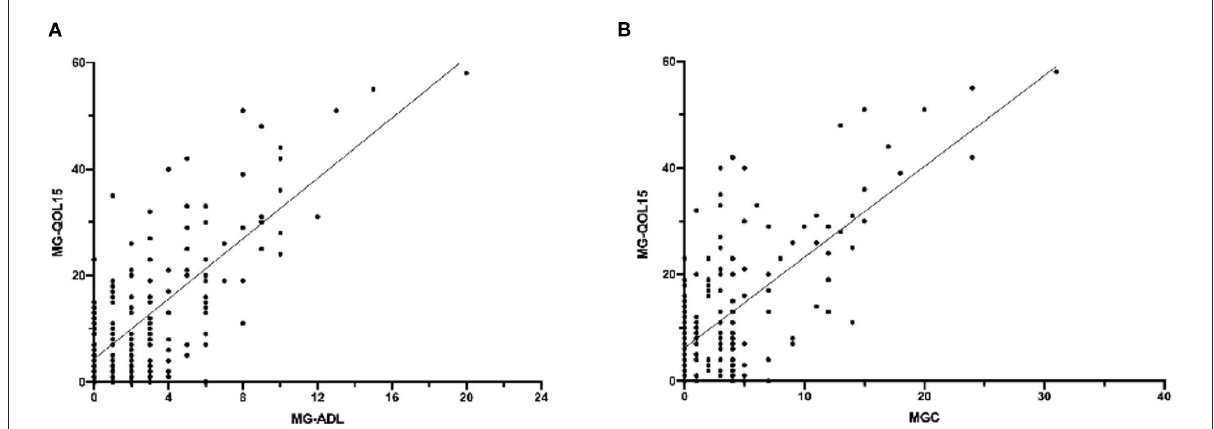
FIGURE4 The correlation of MG-QOL5 with MG-ADL and MGC. (A) MG-ADL was positively correlated with MG-QOL15, P < 0.001, r = 0.734. (B) MGC was positively correlated with MG-QOL15, P < 0.001, r = 0.696. MG-QOL15, the 15-item Myasthenia Gravis Quality of Life; MG-ADL, myasthenia gravis activities of daily living; MGC, myasthenia gravis composite.